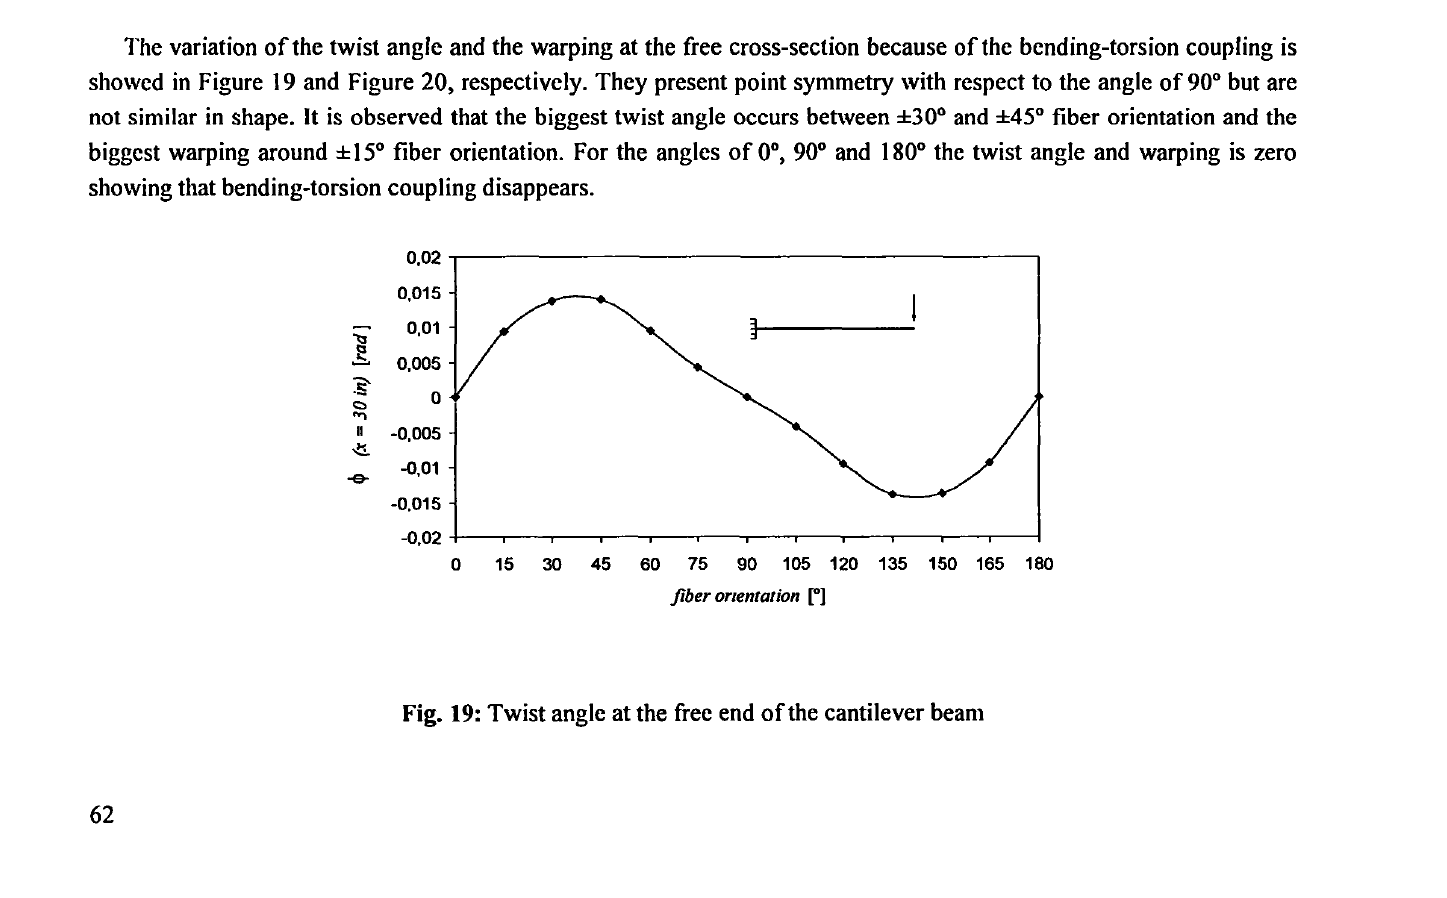
Fig. 18: Bending slope at the free end of the cantilever beam